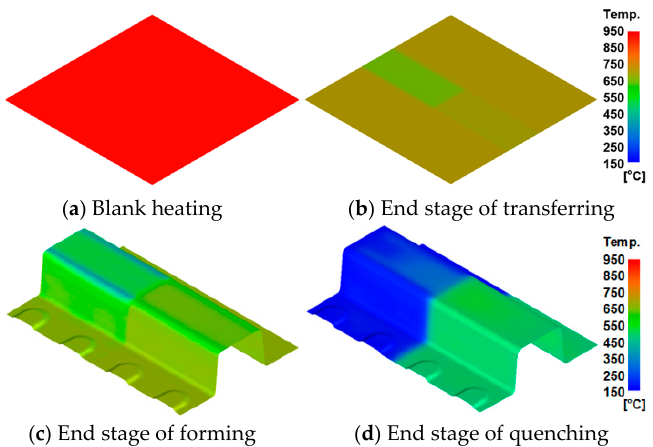
Figure 5. Temperature distributions of partially quenched part for each process at heated tool temperature 400 °C and quenching time 10 s.